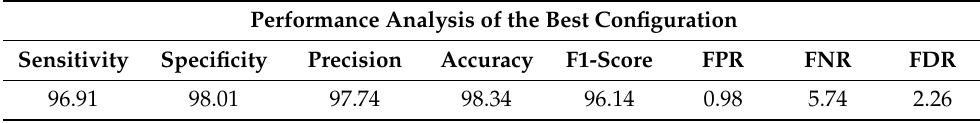
Table 6. Performance evaluation matrix of the optimal configuration of proposed model.